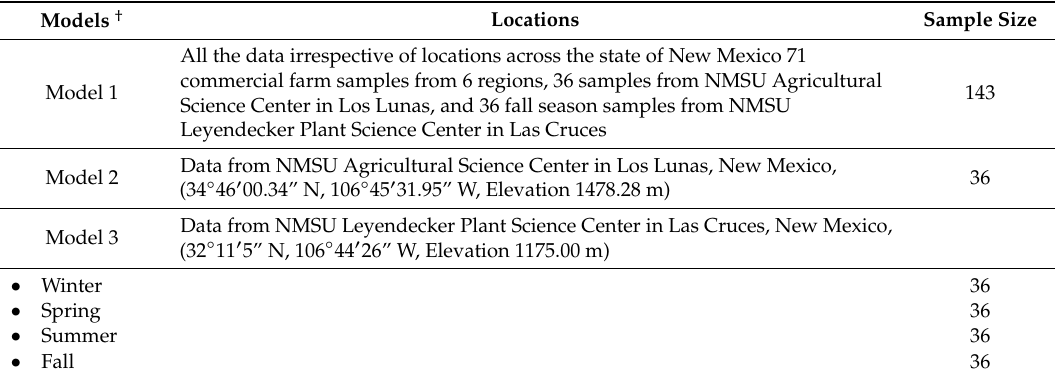
Table 2. Locations used for developing the partial least squares regression (PLSR) models.